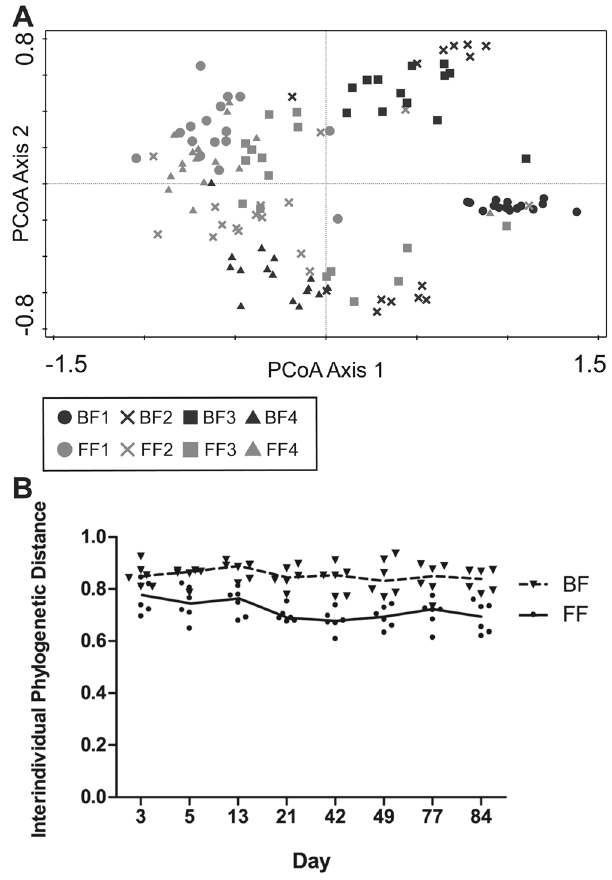
Figure 3. Individuality in breastfed infants versus formula-fed infants. ( A ) Principal Coordinates Analysis (PCoA): unweighted UniFrac interindividual distances of breast- and formula-fed infants are plotted based on similarities/dissimilarities among samples. ( B ) Interindividual distances from day 1 till 12 weeks of age. Unweighted UniFrac interindividual distances are plotted over time for breastfed (BF) infants and formula-fed (FF) infants. Curves represent the